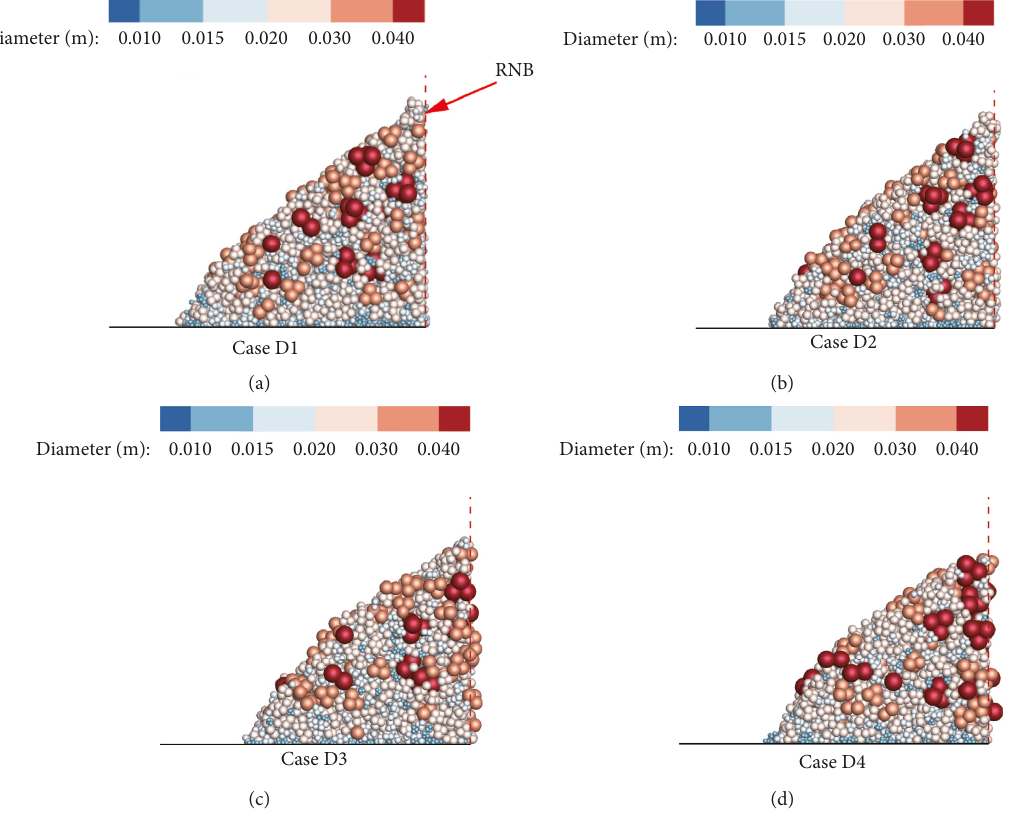
Figure 19: Distribution diagram of the grain